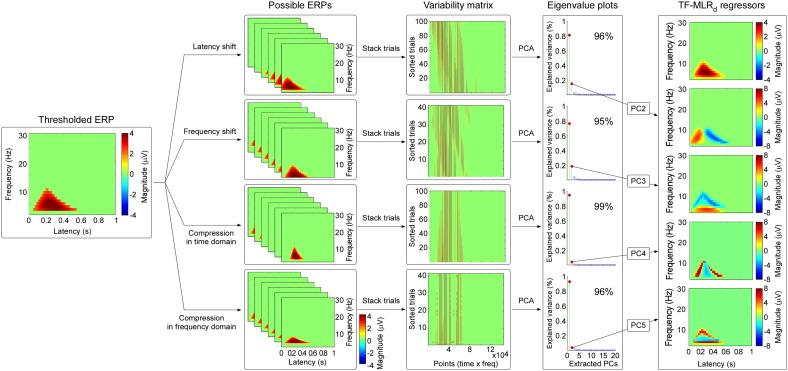
Generation of regressors in the TF-MLRd approach.First column: Time-frequency representation of one of the thresholded features (‘ERP’, in this example) of the EEG response, obtained by PCA decomposition with Varimax rotation (see Fig. 1). Second column: TFDs representing plausible variability in latency, frequency, morphology in the time domain, and morphology in the frequency domain were generated by shifting and compressing the thresholded response in an enumerative fashion. Third column: For each source of variability, the plausible responses were re-arranged into vectors, which were subsequently stacked into a data matrix (variability matrix). Fourth column: The eigenvalue plots show the explained variance for each of the first 20 generated PCs, for each variability matrix. Note that the first two PCs explain the largest part of the total variance of each source of variability. Fifth column: Five regressors capturing the average magnitude of the considered TF-feature, and its variability in latency (the second PC in latency-shift variability matrix), in frequency (the second PC in frequency-shift variability matrix), in morphology in the time domain (the second PC in latency-compression variability matrix), and in morphology in the frequency domain (the second PC in frequency-compression variability matrix).